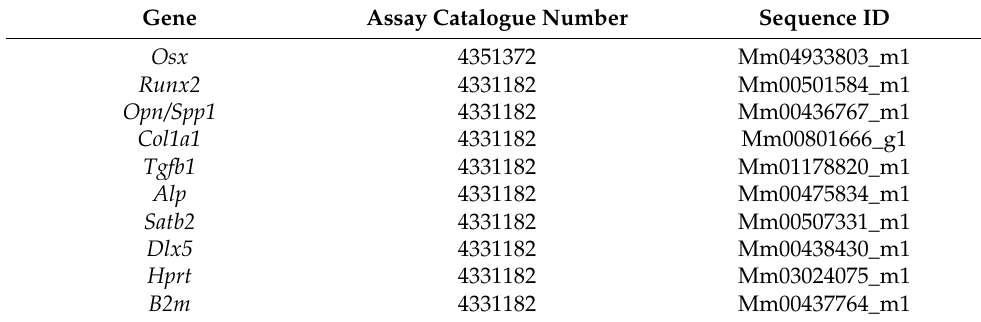
Table 1. Gene and assay ID